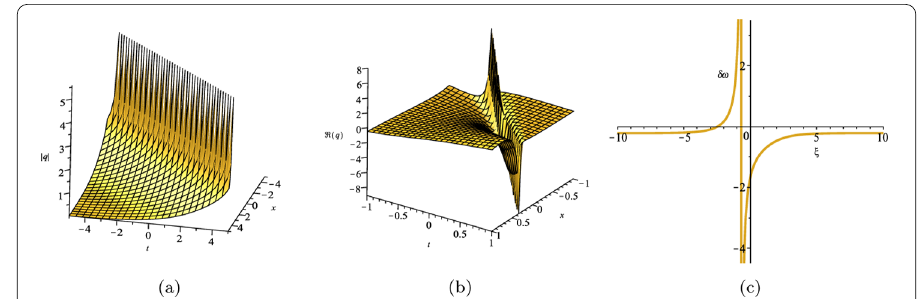
Figure 7 Chirped singular soliton solution (42) with a 1 = 4, a 2 = 1, b = 2, α = 2, λ = 6, μ = 1, ν = 1, σ = 2, Ω = 3. ( a ) Modulus. ( b ) Real part. ( c ) Corresponding